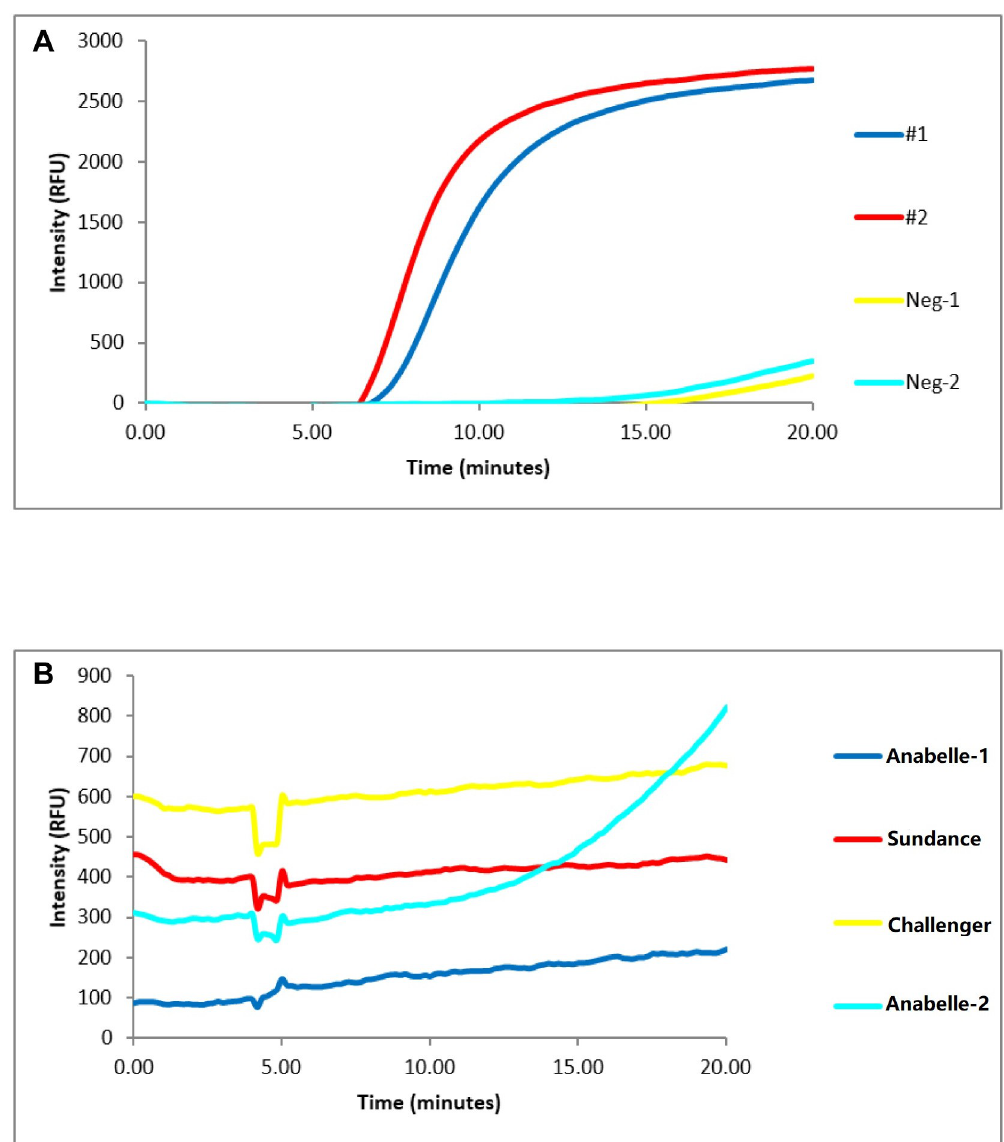
Fig 3. Detection of potato mop-top virus (PMTV) using real-time duplex RPA assay. (A) RNA samples from two infected tubers and two healthy tubers. (B) Tuber samples were prepared by crude